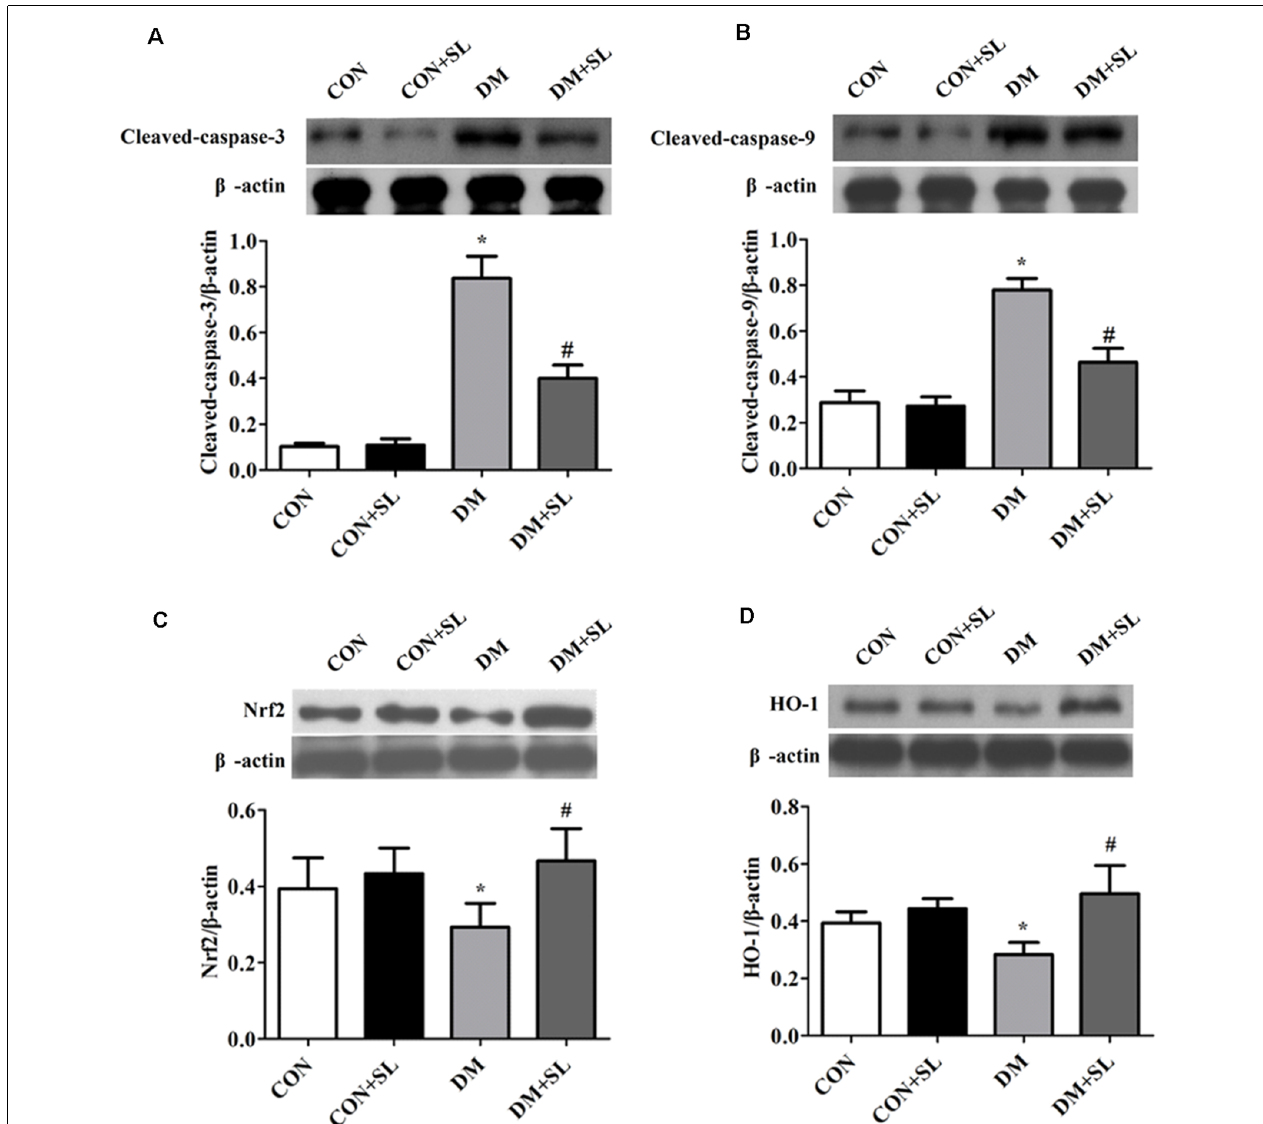
FIGURE 6 | Effect of strawberry leaf extract on the expression of caspase-3, caspase-9, Nrf2, and HO-1. The protein of the five animals per group pulled and used in the electrophoresis, and then select a representative one. The results were the means of five tests. (A–D) Representative western blot images of caspase-3, caspase-9, Nrf2, and HO-1. The data in each group are shown as the mean ± SD. The values are the ratio of target proteins to β -actin. * p < 0.05 vs. CON group; # p < 0.01 vs. DM group, n =